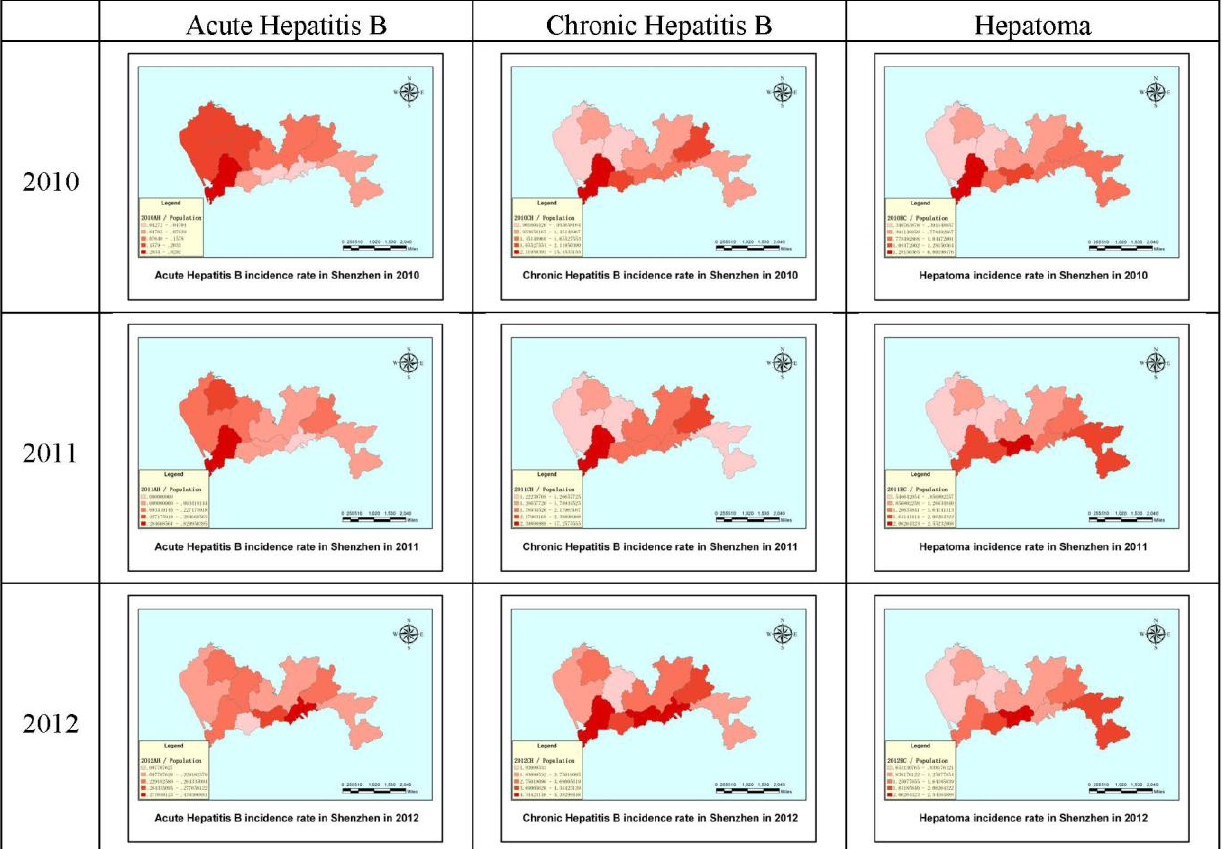
Figure 6. The incidence rates of hepatitis B and hepatoma in Shenzhen in 2010, 2011 and